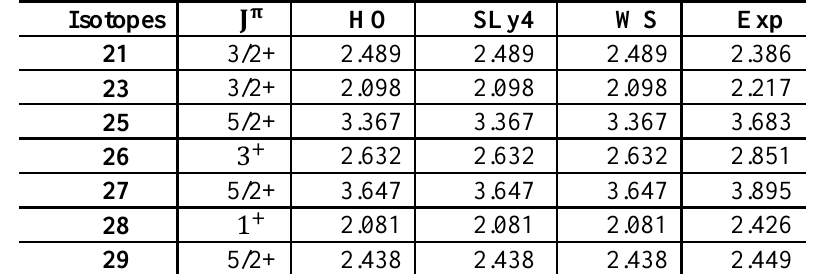
Figure 2: The calculated magnetic dipole moments μ (nm) for Na-isotopes using different two- body effective interactions in comparison with the experimental data of Refs. [16, 17] . Table 2: Theoretical calculated magnetic dipole moments μ (nm) for Na-isotopes using three different single-particle potentials; HO, WS, and SLy4 in comparison with experimental data from Refs. [16, 17].